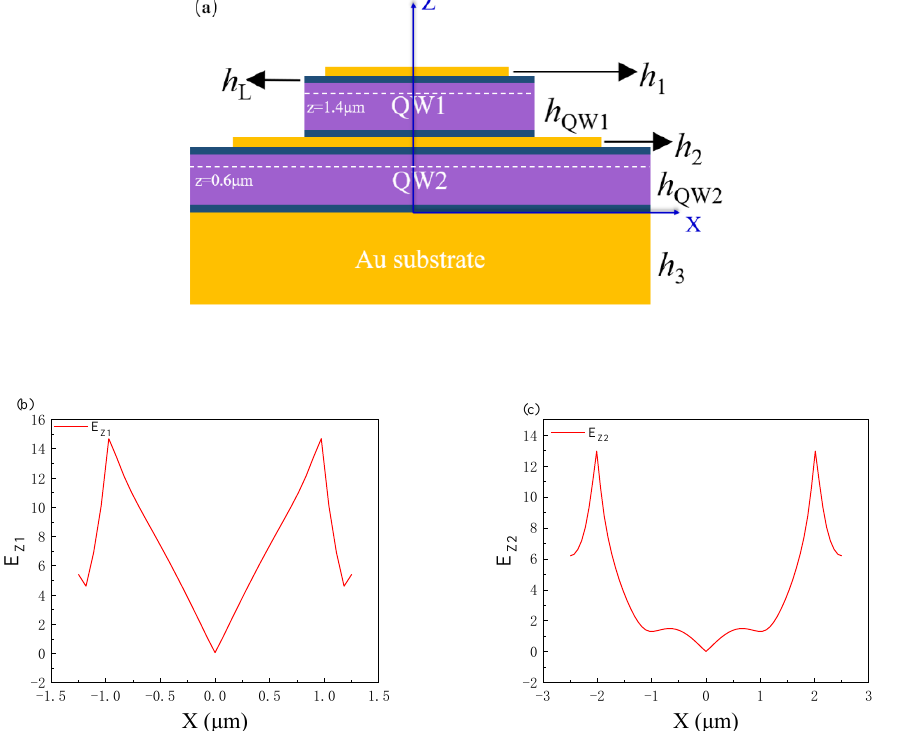
Figure 4. ( a ) At the x-z plane ( y = 0) of the device, take the zero point at the center of the device at the metal-semiconductor interface to establish the coordinates. ( b ) The electric field component E Z in QW1 changes with the x-axis ( y = 0, z = 1 .4 μm) and ( c ) the electric field component E Z in QW2 changes with the x-axis ( y = 0, z = 0 .6 μm) .